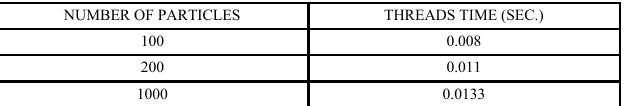
Figure 31. Threads time: in the parametrization of the filter, the adjustment of the number of particles is made taking into account the processing time of each frame. It is intended to observe the target at a minimum rate of 10 frames per second (less than 100 ms). This is due to the fact that the control operates at 20 Hz and it is not desired that there is more than one estimation between two consecutive frames. That is, it is desired that the algorithm has a processing time of less than 10 ms. The processing time of the developed filter for 1000 particles occupies 13 ms of the total processing time. In addition to the detector/estimator processing time (83 ms) it is found that the goal of a total processing time of less than 100 ms has been achieved. The equipment used was the developed vision module (Camera Bowtech + Raspberry Pi) whose characteristics are described at the beginning of this